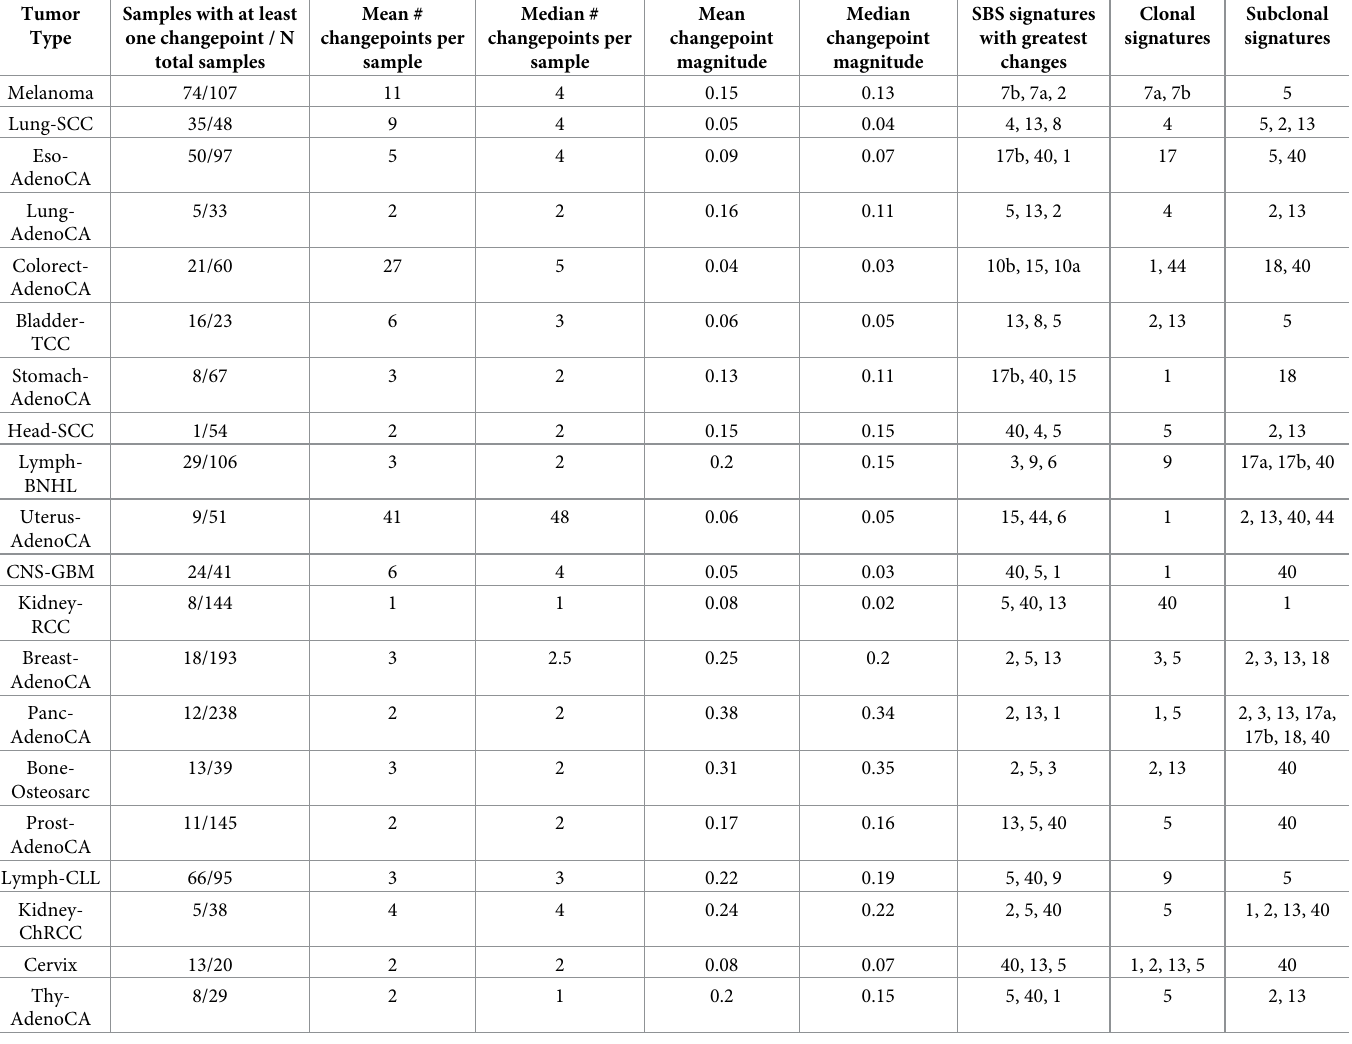
Table 1. Overview of changepoints discovered across 20 cancer types. Magnitude of each changepoint is measured as the cosine distance of the signature activity vector on either side of the changepoint. For each cancer type containing changepoints, the three signatures with the greatest absolute value of activity changes across all change- points in that cancer are listed. Signatures are indicated as “clonal” or “subclonal” respectively based on where their activity is highest, as described by [5]. Tumor